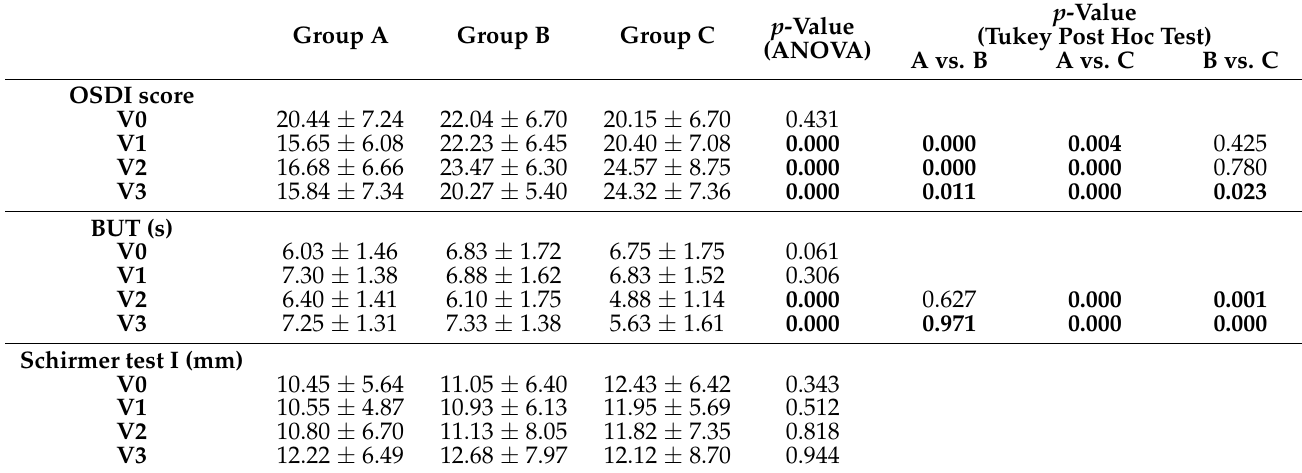
Results are reported as mean ± SD. p -values highlighted in bold are statistically significant. Abbreviations: OSDI, Ocular Surface Disease Index; BUT, break-up time; SD, standard deviation; s, seconds; ANOVA, analysis of variance; vs., versus; V0, preoperative visit; V1, the